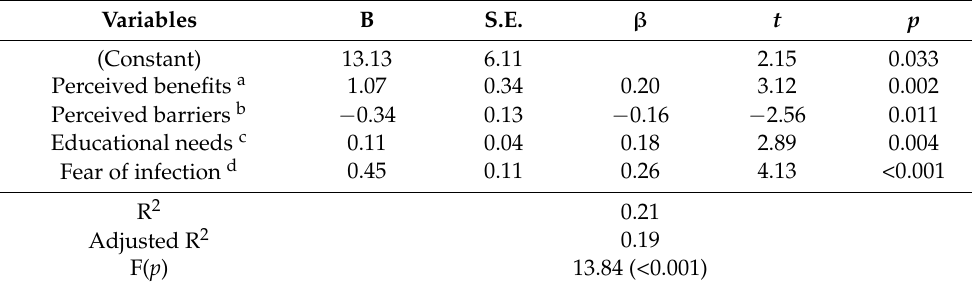
Table 4. Factors affecting COVID-19 preventive health behaviors. Variables